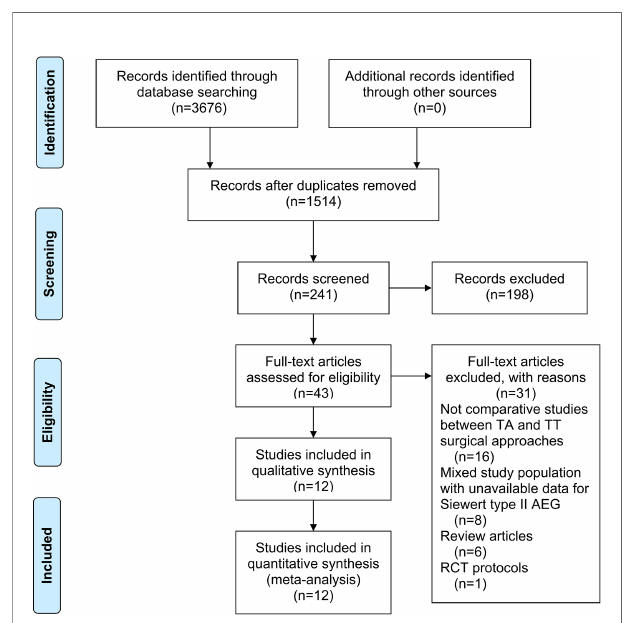
FIGURE 1 | PRISMA fl owchart of literature search and selection process. PRISMA, preferred reporting items for systematic review and meta-analysis;